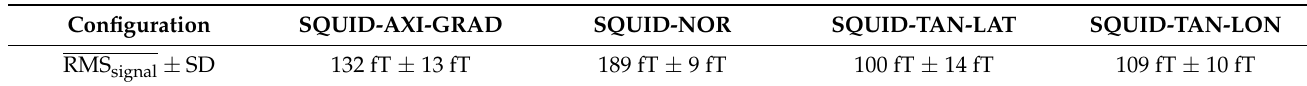
Table 2. The average RMS signal of the simulated MFM without noise for four different SQUID-MEG configurations.